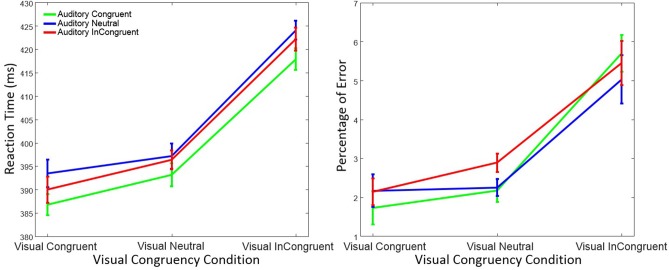
Mean reaction time (left figure) and mean percentage of response errors (right figure) in Experiment 2 as a function of visual and auditory congruency. Error bars were computed according to Morey's method (Morey, 2008).